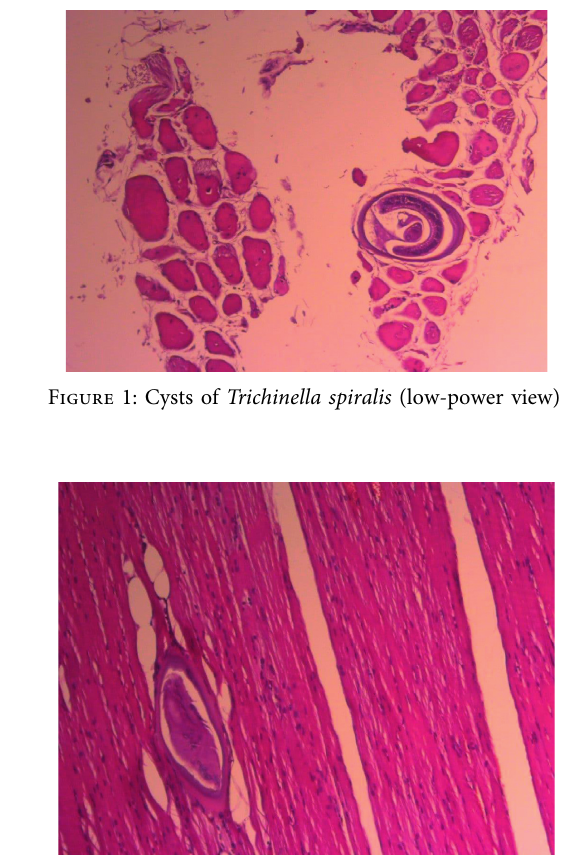
Figure 2: Encysted Trichinella spiralis (low-power view).